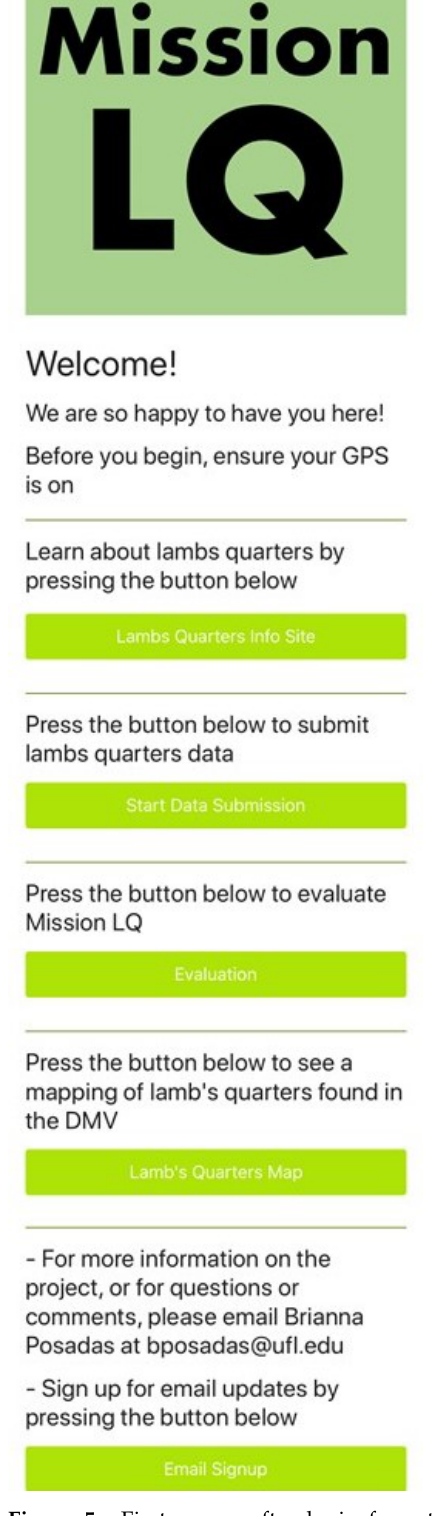
Figure 5. First screen after login from the second design iteration for the iPhone version of Mission